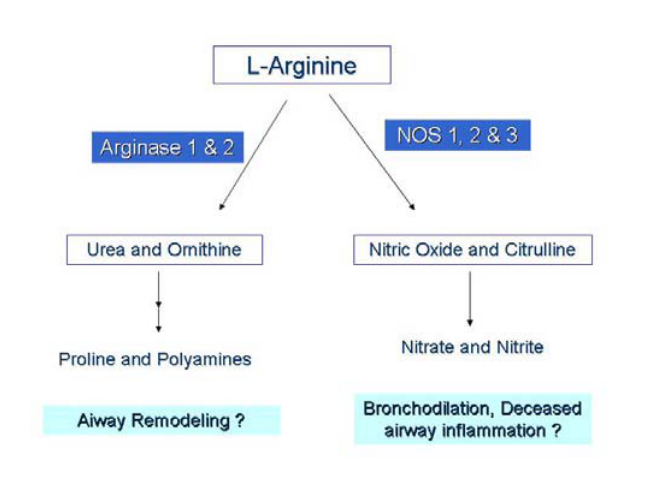
Figure 2. Diagram depicting the major pathways and downstream metabolites of L -arginine. Nitric oxide synthase enzymes (NOS 1, 2, 3) may be in direct competition with arginase for the substrate L- arginine, thereby affecting nitric oxide production.